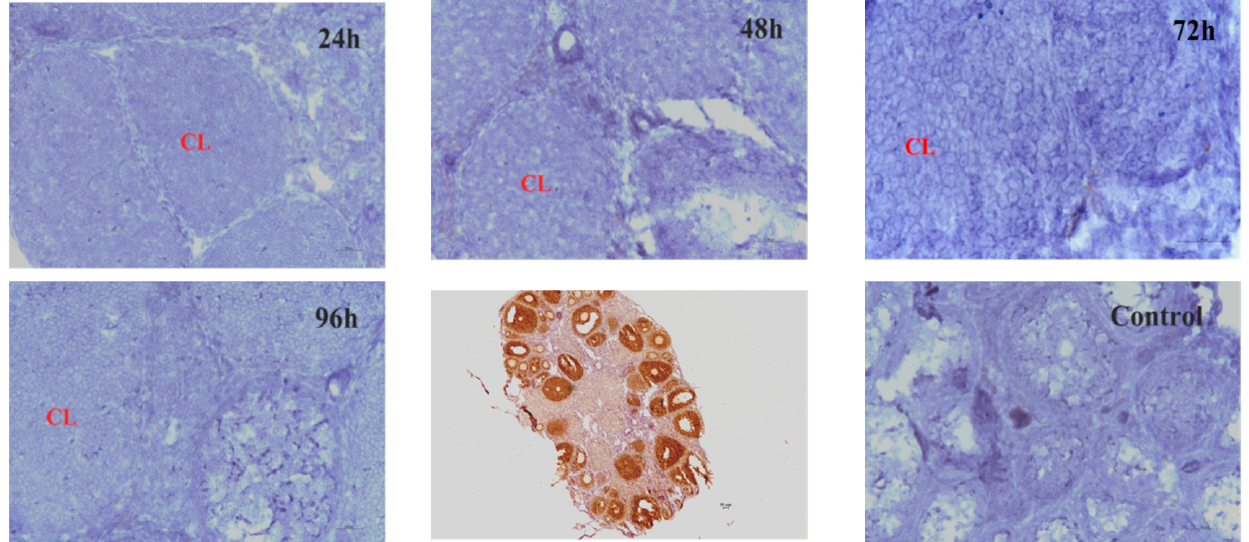
Figure 2. Hand2os1 expression in the hCG-induced CL formation and regression model for different hours (24 h, 48 h, 72 h, 96 h) was detected by RNAscope. Positive expression results in a brown colour. CL, corpus luteum. Scale bar = 50 μ m.